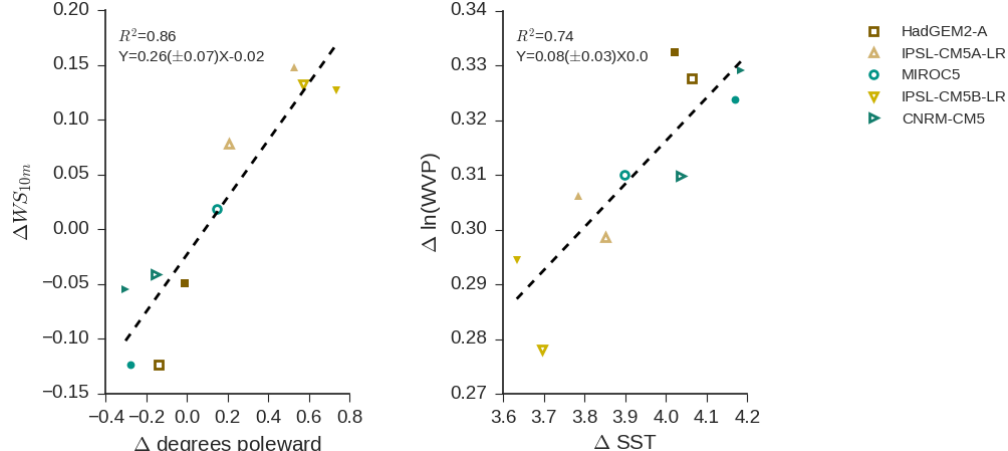
Figure 9. Changes in cyclone-mean wind speed at 10m (WS 10m ) and the natural log of WVP between AMIP and AMIP + 4K simulations plotted against changes in mean poleward cyclone latitude and SST, respectively. Open symbols show the change over the NH and closed symbols show the change over the SH. The best fit line to the NH and SH is noted in each plot along with 95% confidence in the slope.